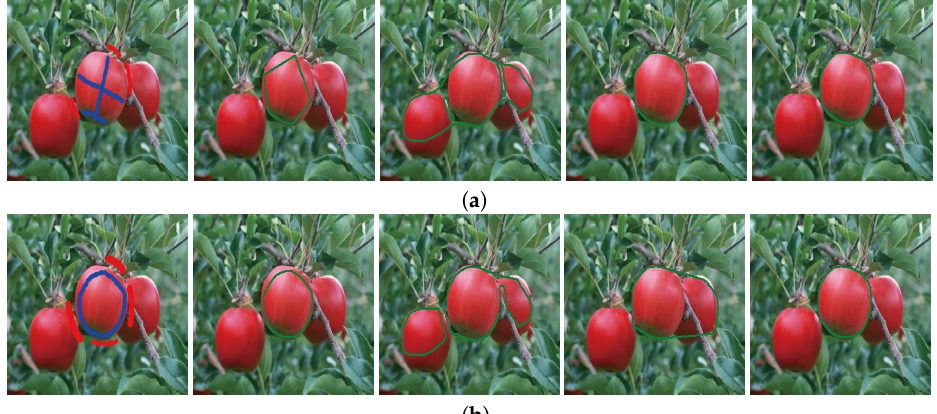
Figure 5. Comparison of image segmentation results with different initial contours, where the first column and the second column shown in ( a , b ) show the original images and the initial contours of foreground regions, respectively, and the last three columns in ( a , b ) are the image segmentation results obtained from the BLF–TV–CS method, the FMF–TV–CS method and our proposed PPA–CS method, respectively.